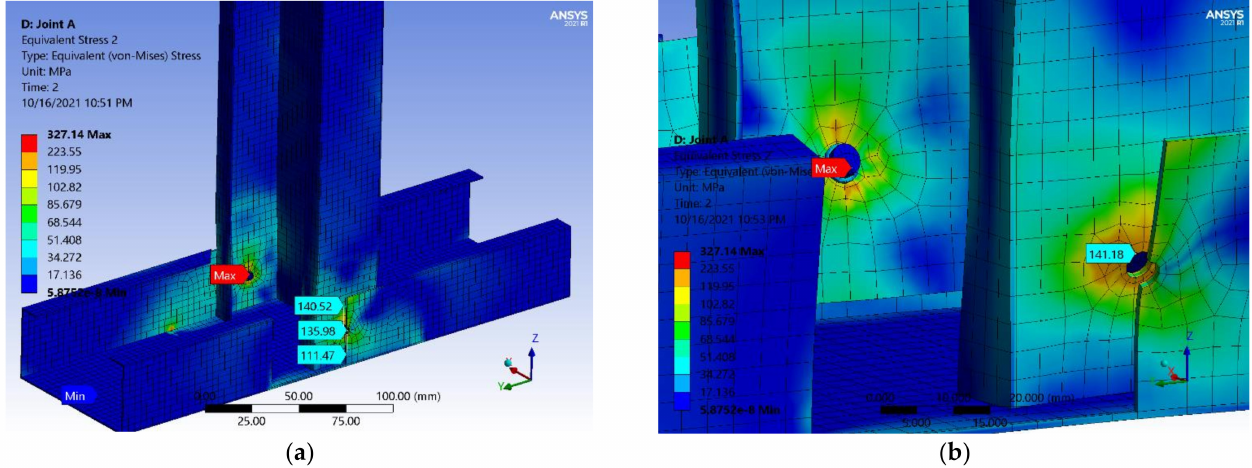
Figure 24. Equivalent stress von Mises joint A: ( a ) map distribution; ( b )detail near hole and screws